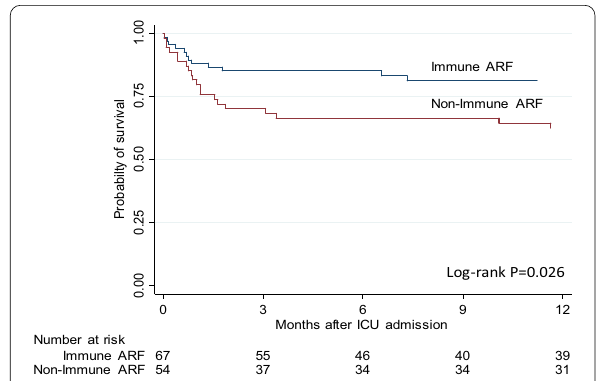
Fig. 2 Kaplan–Meier estimates of the survival rates at 1 year from ICU admission for acute respiratory failure (ARF) in patients with Svv, comparing patients with a predominant immune (red curve) or non‑immune (black curve) cause of ARF. Only the first admission was considered for the survival